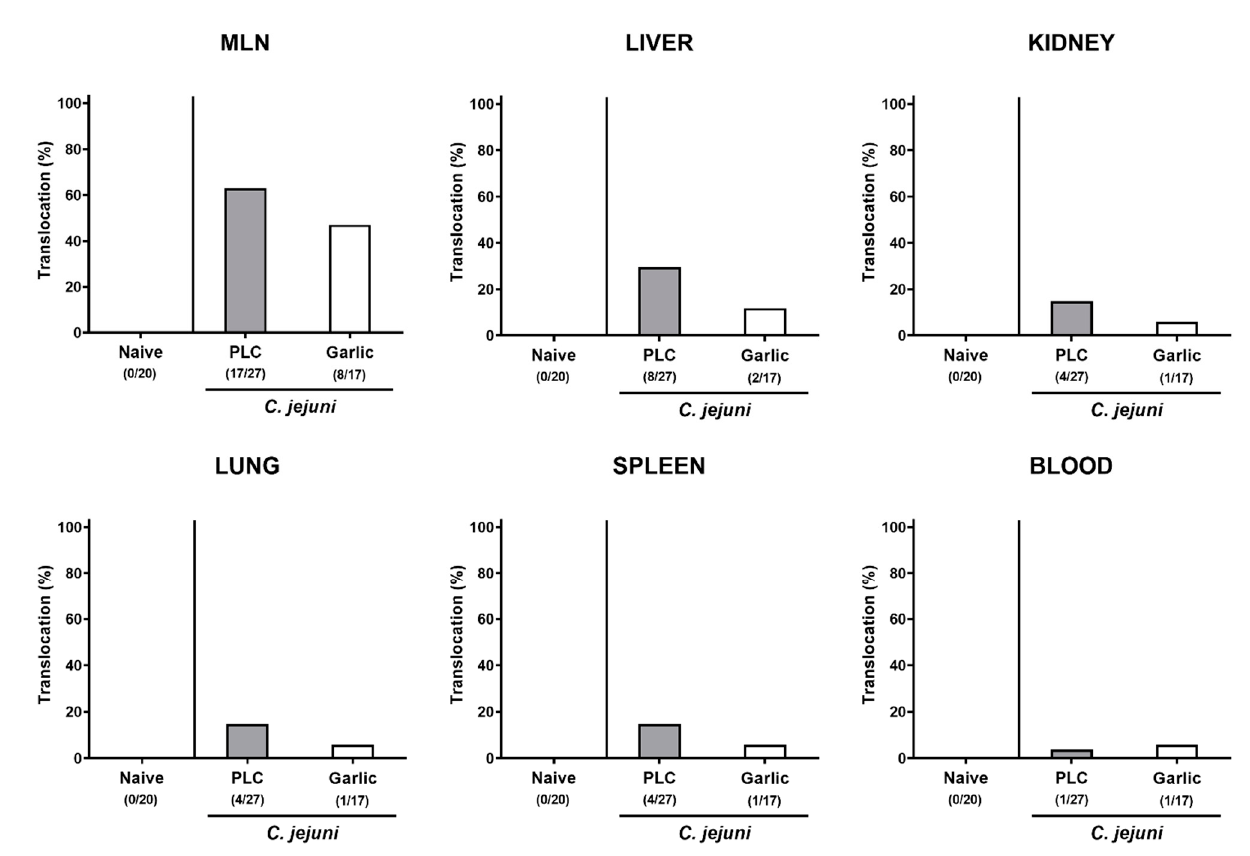
Figure 9. Bacterial translocation upon garlic essential oil treatment of C. jejuni infected IL-10 -/- mice. Secondary abiotic IL-10 -/- mice were orally challenged with C. jejuni strain 81–176 on days 0 and 1 followed by treatment with either garlic essential oil (white bars) or placebo (PLC, gray bars) via the drinking water starting on day 2 post-infection. Bacterial translocation frequencies (in %) were determined in explants taken from the mesenteric lymph nodes (MLN), liver, kidney, lung, and spleen and in cardiac blood (as indicated) on day 6 post-infection by culture. Naive mice (hatched bars) served as non-infected and untreated cohort. Bars indicating the translocation frequencies (in %) and the numbers of culture-positive out of the total number of analyzed samples (in parentheses) are shown (pooled data from four independent experiments).